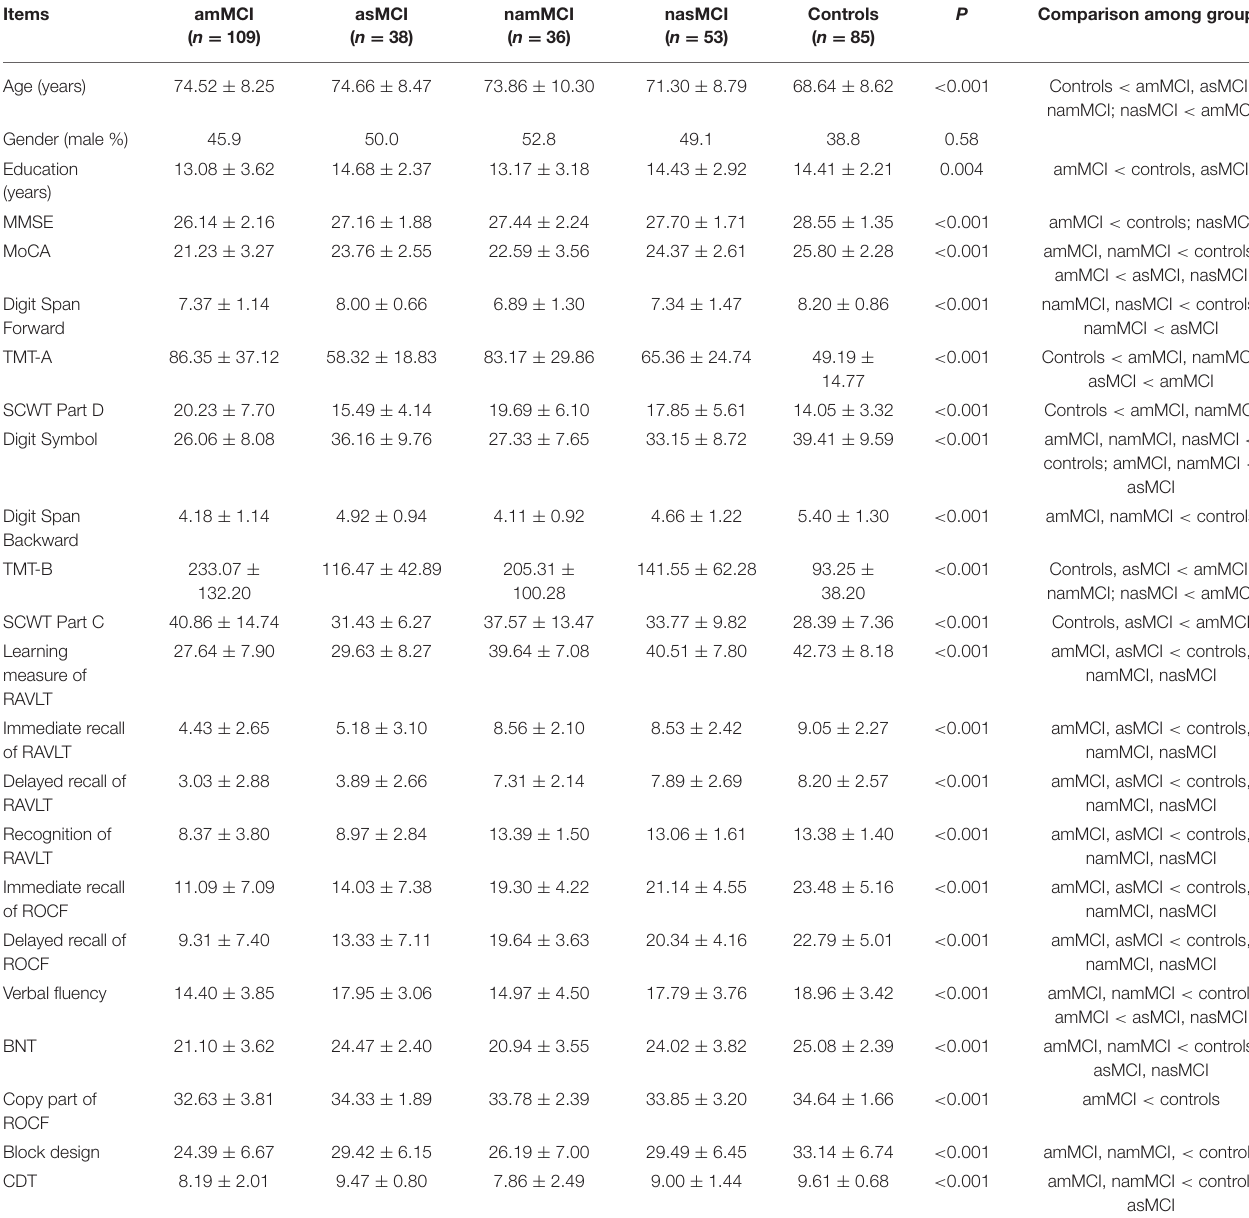
TABLE 1 | Demographic, cognitive data of the patients with different MCI subtype and the healthy controls.